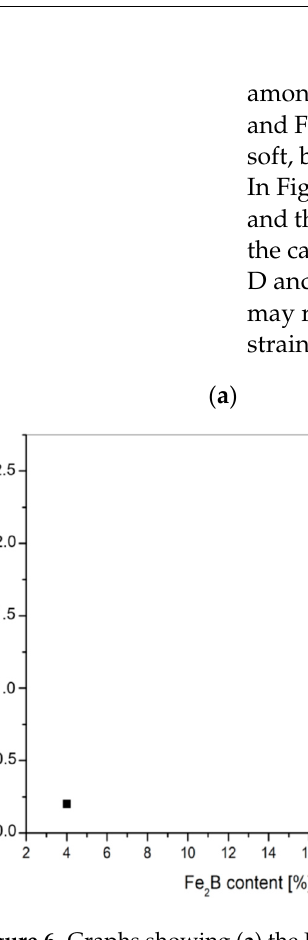
Table 8. Average values of microhardness of the Fe-B-La-Al alloy tapes. Sample